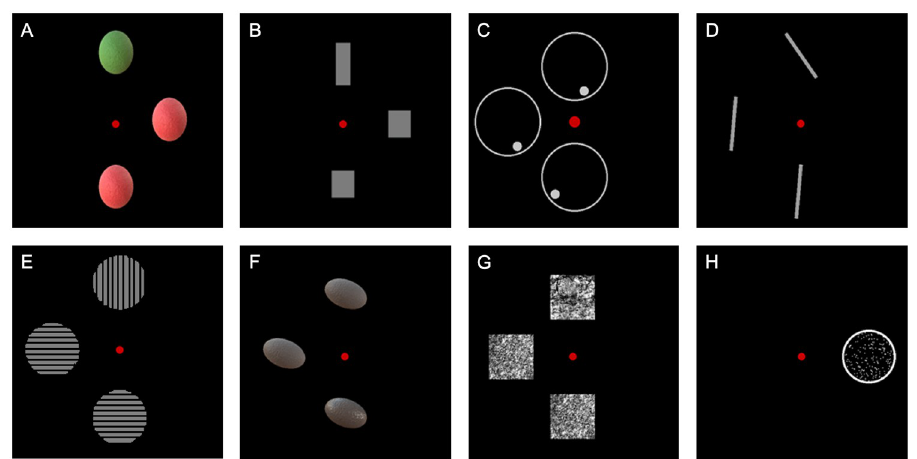
Fig 1. Examples of stimulus-pictures used to assess the perception of A) color, B) shape, C) location, D) orientation, E) contrast, F) glossiness, G) texture and H) correlated motion.